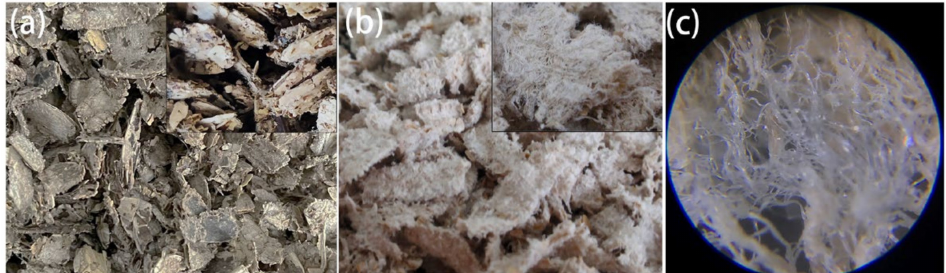
Figure 2. Photographs of E. ulmoides pericarps before and after enzymatic hydrolysis. ( a ) before, ( b ) after, ( c ) optical micrograph of gutta-percha in enzymatic hydrolyzed E. ulmoides pericarps ( ×